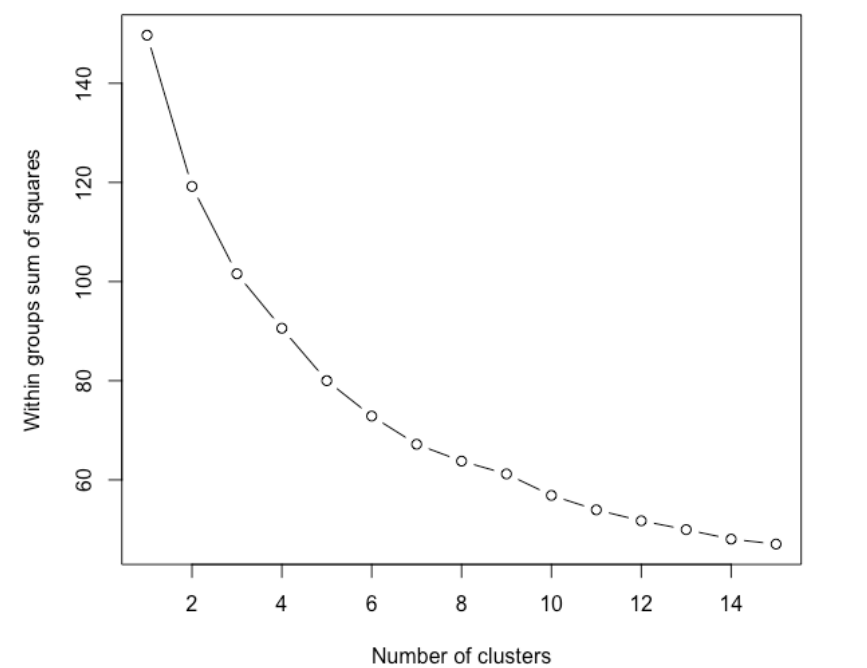
Figure 1. Within-cluster sum of squared errors for all patients, both male and female. The elbow method indicates that the best value of k is 7, meaning there are 7 clusters.